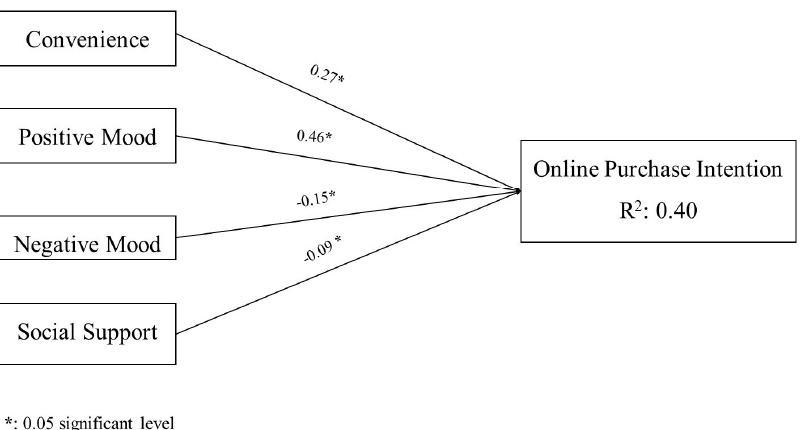
Figure 2. Research model result.